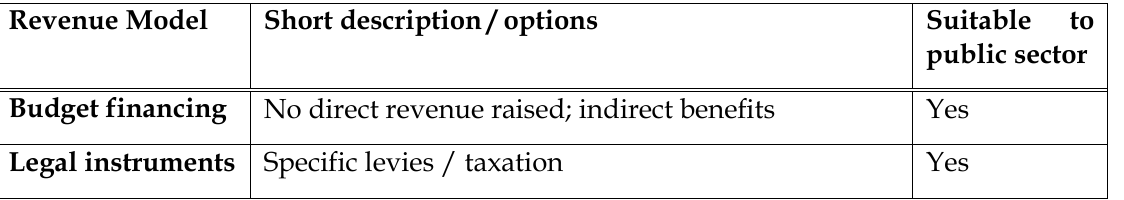
Table 1: Revenue models and their suitability for public sector organisations Revenue